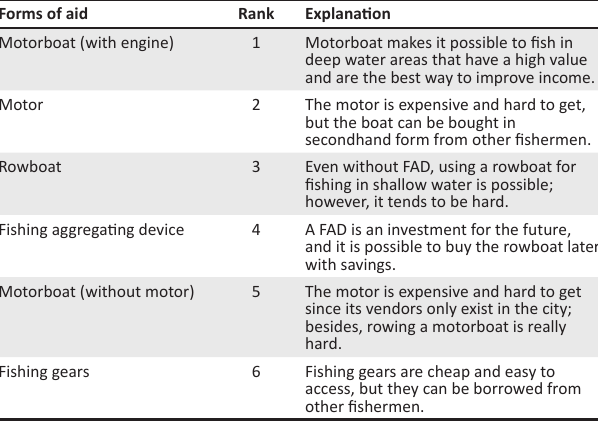
TABLE 3: Loli Dondo fishermen organisation’s priority ranking on the forms of aid. Forms of aid Rank Explanation Motorboat (with